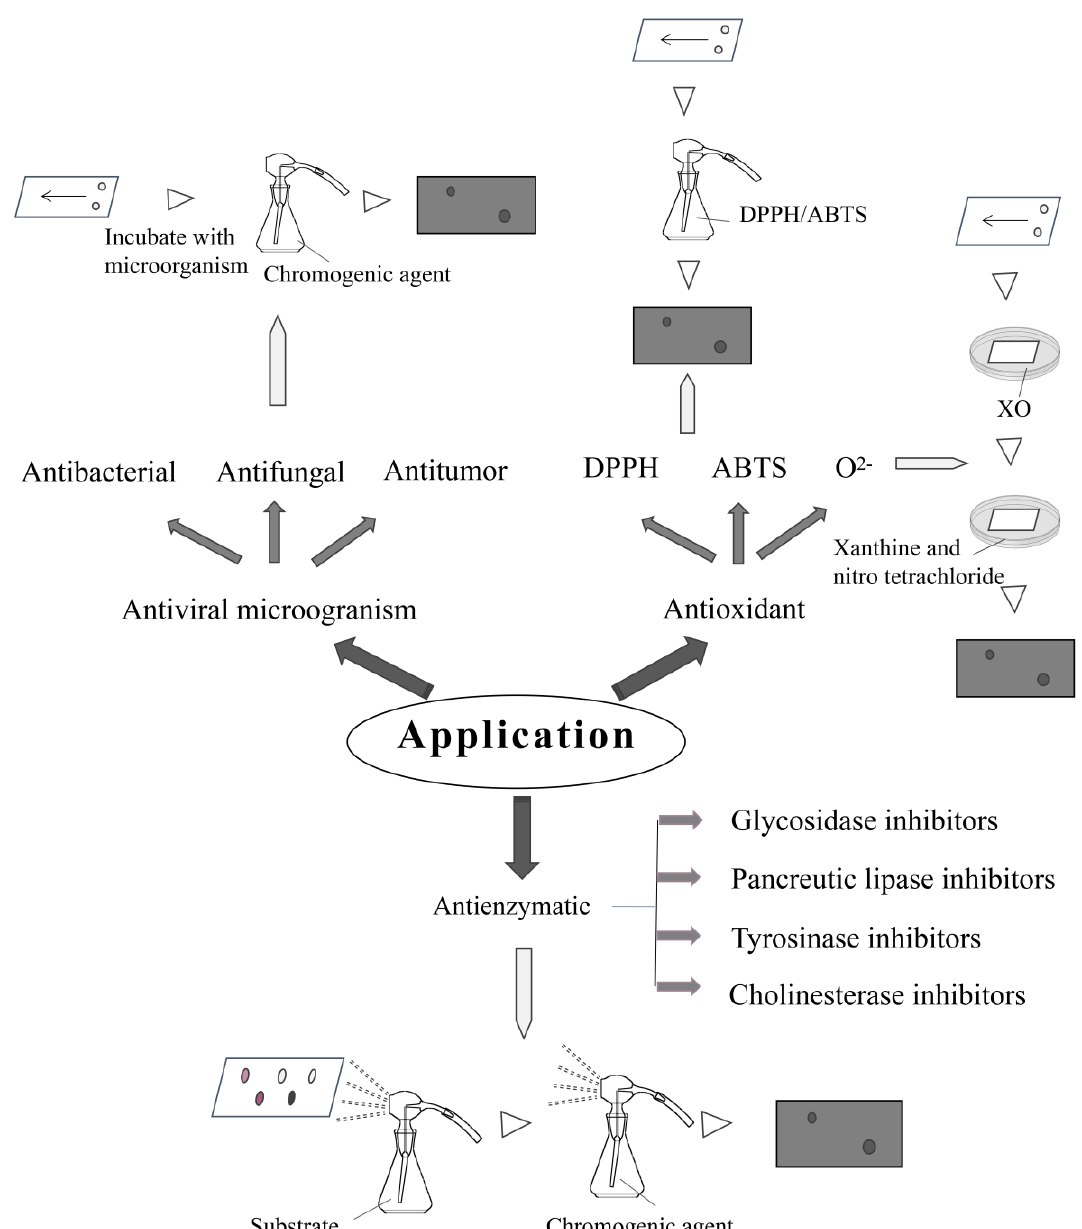
Figure 4. Principle of different applications in TLC bioautography. The application of TLC bioautography is mainly divided into antiviral, antioxidant and anti-enzymatic, and each item is subdivided again. This diagram illustrates the different principles of the application of this technique.